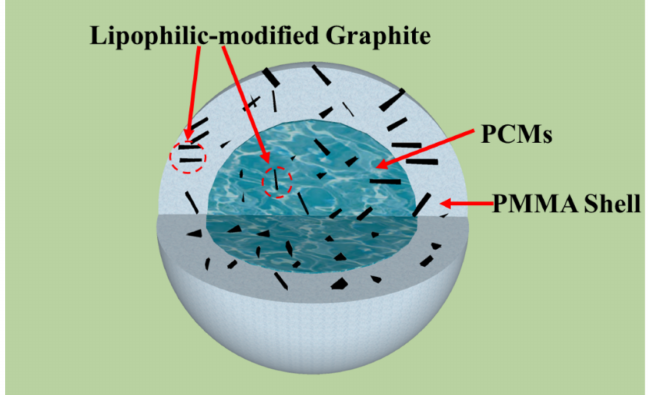
Figure 1. Structure diagram of